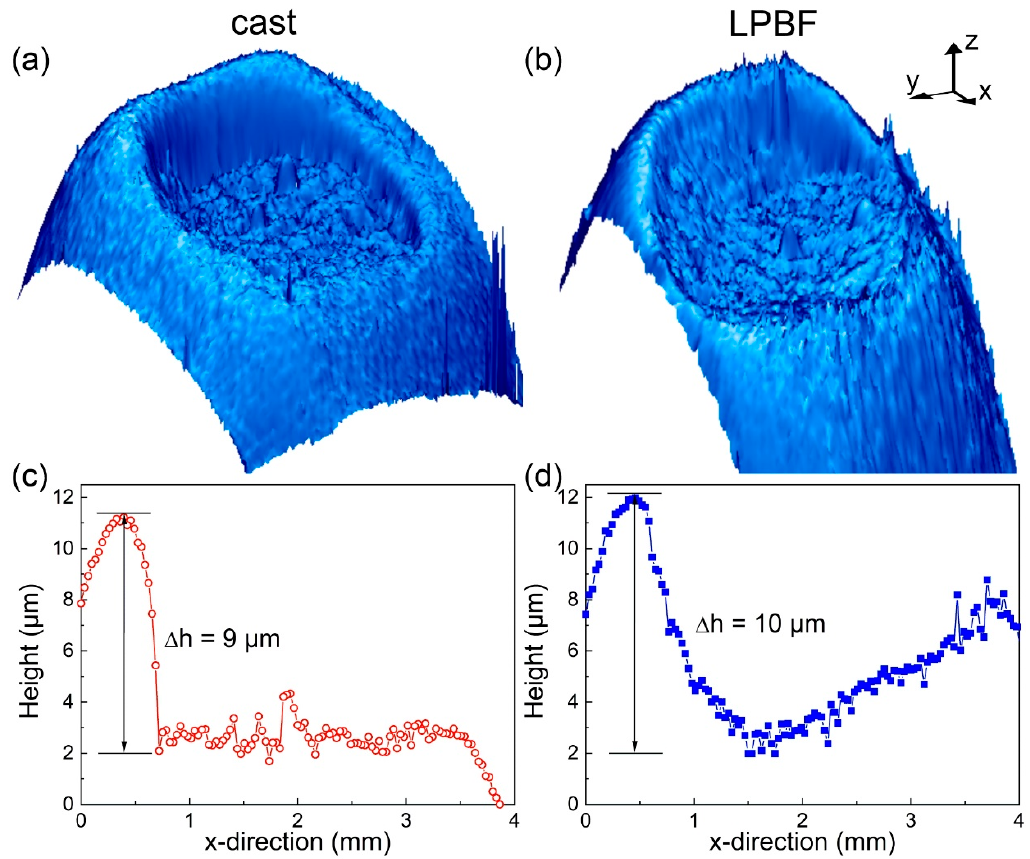
Figure 5. Topographies of the Zr 52.5 Ti 5 Cu 18 Ni 14.5 Al 10 BMGs fabricated by ( a ) casting and ( b ) LPBF after thermoplastic embossing. Depth profiles along the x-direction quantifying the sharpness of the indentations in the BMGs fabricated by ( c ) casting and ( d ) LPBF.